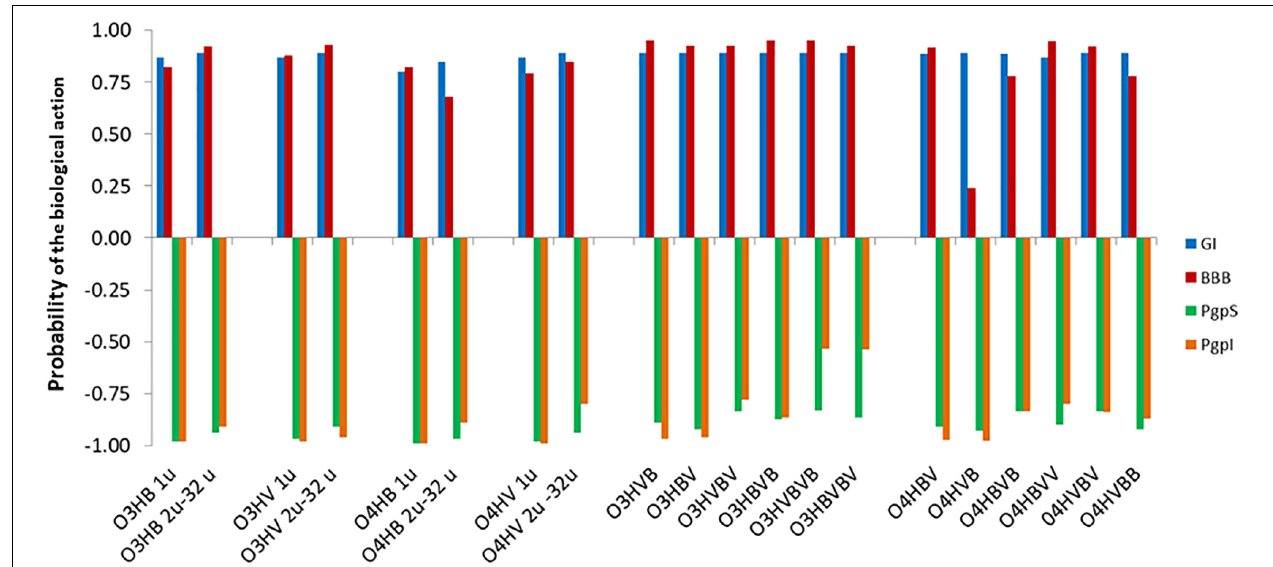
FIGURE 2 | Absorption profiles of low molecular weight oligo-hydroxyalkanoates calculated with admetSAR2.0: u denotes the number of units in the oligomer, O3HB denotes the oligomer of 3HB, O3HV denotes the oligomer of 3HV, O4HB denotes the oligomer of 4HB, O4HV denotes the oligomer of 4HV. In the case of co -oligomers, BV, VB, BVB, VBV, BVV, VBB, BVBV, and VBVB, respectively, illustrate the succession of the 3-hydroxybutyrate/4-hydroxybutyrate (B) and 3-hydroxyvalerate/4-hydroxyvalerate (V) monomers in the co -oligomeric chain, respectively. The predicted probabilities for gastrointestinal absorption (GI), for penetration of the blood-brain barrier (BBB), or to be a substrate or an inhibitor pf P-glycoprotein (PgpS/PgpI) take values between 0 and 1 in the case of a biological activity that is present and between − 1 and 0 when the activity is considered absent. For values closer to 1, the biological effects are highly probable and values closer to − 1 correspond to highly improbable biological effects.